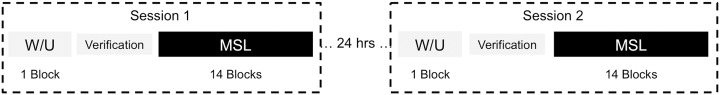
Experimental Design.See text for details of each phase. W/U = warm-up.